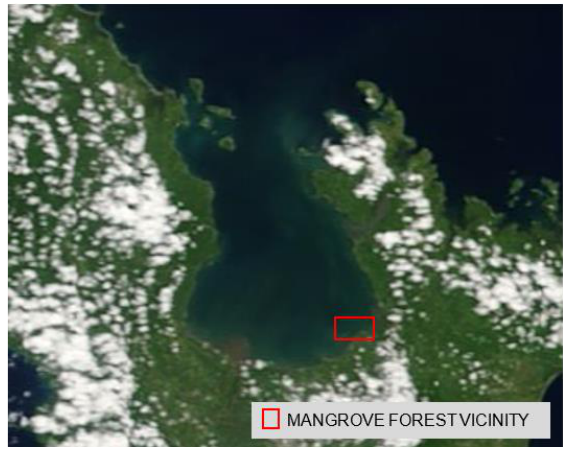
Figure 1 . San Miguel Bay (Nasa, 2020)